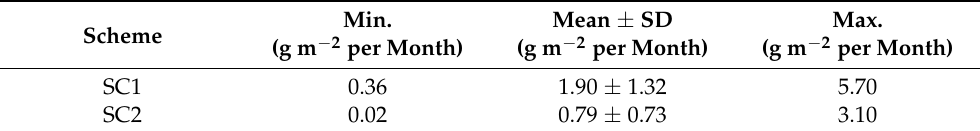
Table 5. Dust flux deposition for the SC1 and